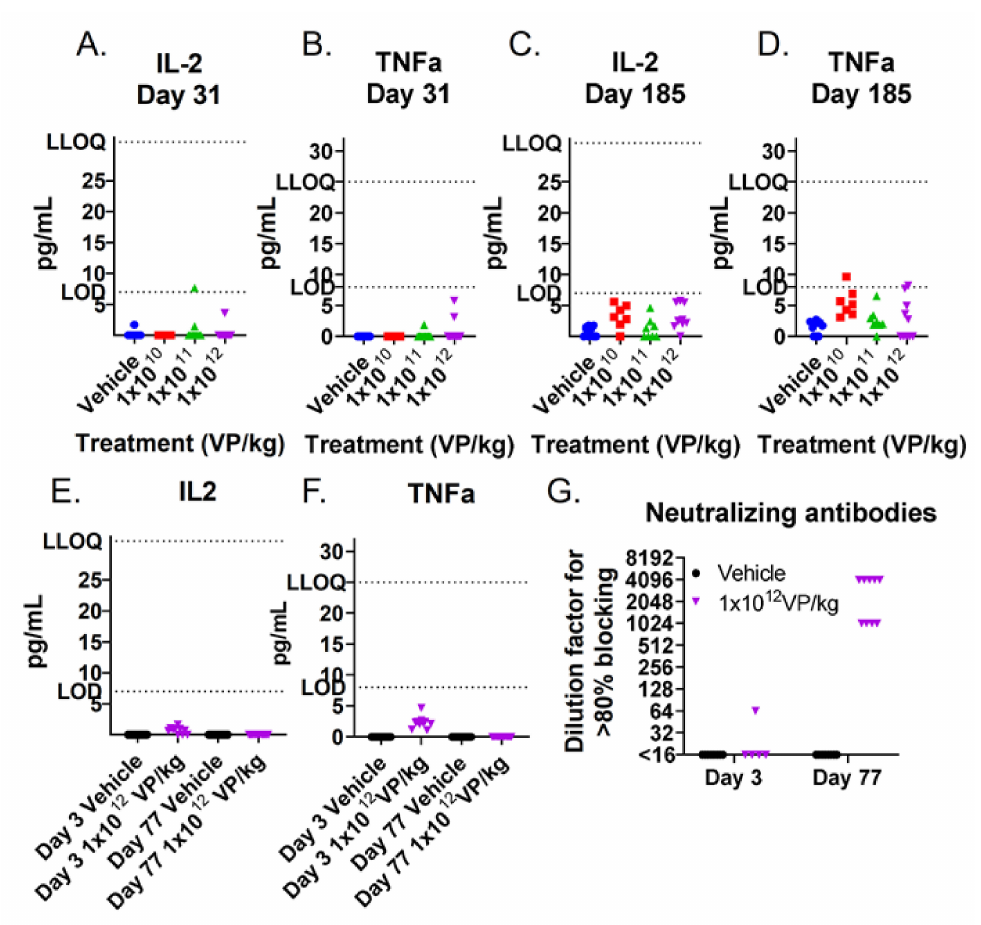
Figure 4. TILT-123 transgene expression and neutralizing antibodies in hamster sera: human TNFa and IL-2 were analyzed from hamster sera by ELISA after three i.p. injections on day 31 ( A , B ) and after six injections at the end of the experiment (day 185) ( C , D ). In addition, the transgene expression ( E , F ) and Ad5/3 neutralizing antibodies ( G ) were measured after one i.v. injection (day 3) and two weeks after the last i.p. injection (day 77). LOD: Limit of Detection; LLOQ: Lower Limit of